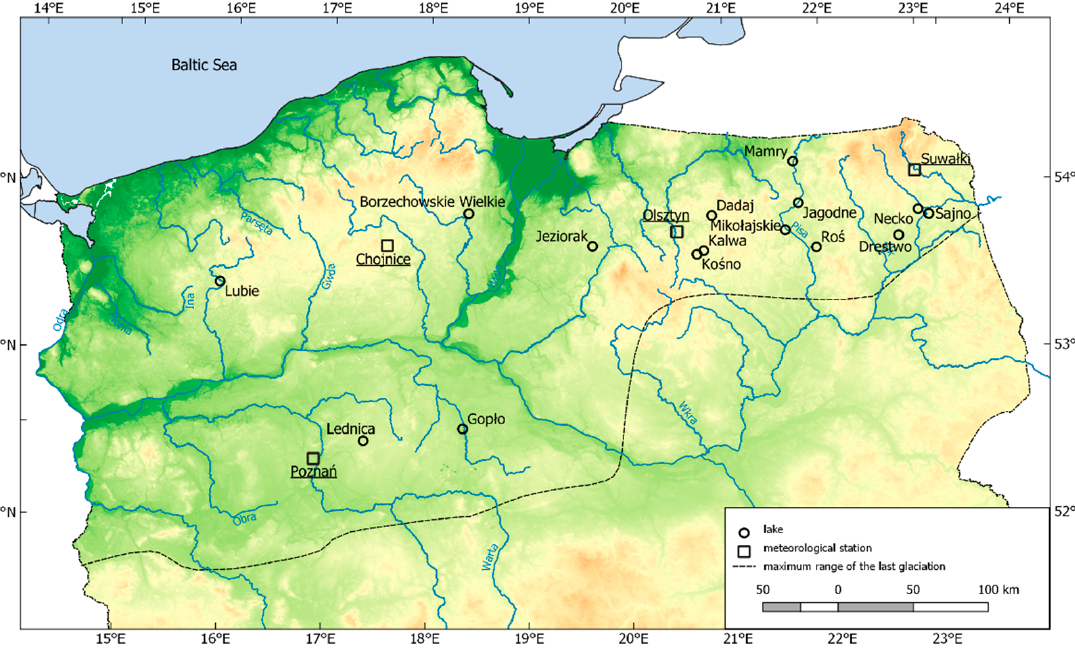
Figure 1. Location of the lakes.